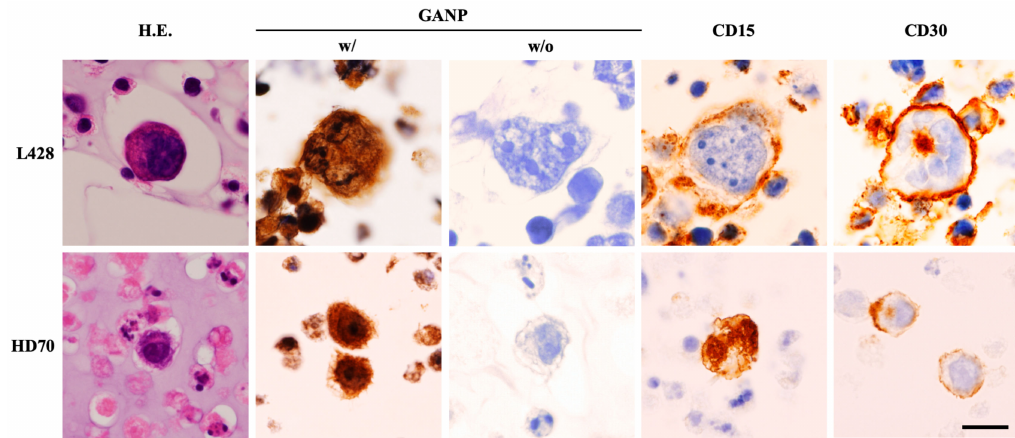
Figure 1. Hematoxylin and eosin staining and immunocytochemistry of the Hodgkin lymphoma cell lines L428 and HD70. Both cell lines have medium-to-large-sized cells exhibiting a bizarre nucleus with a large nucleolus. Multinucleated Reed–Sternberg cells are observed. Immunocytochemically, these cells are positive not only for the diagnostic markers CD15 and CD30 but also for germinal center-associated nuclear protein (GANP). Immunoreactivity is completely lost when an anti-GANP monoclonal antibody (42-23) is omitted from the immunocytochemical procedure (negative control). Scale bar = 25 µ